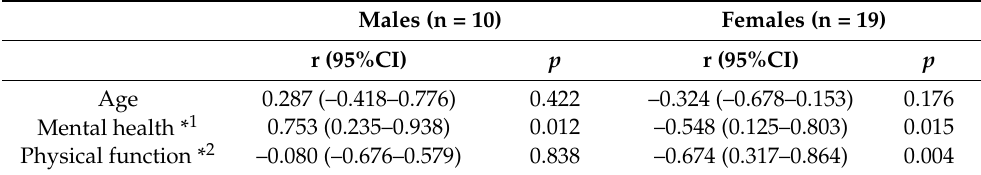
Table 3. Correlation between IADL and possible associated factors (stratified by